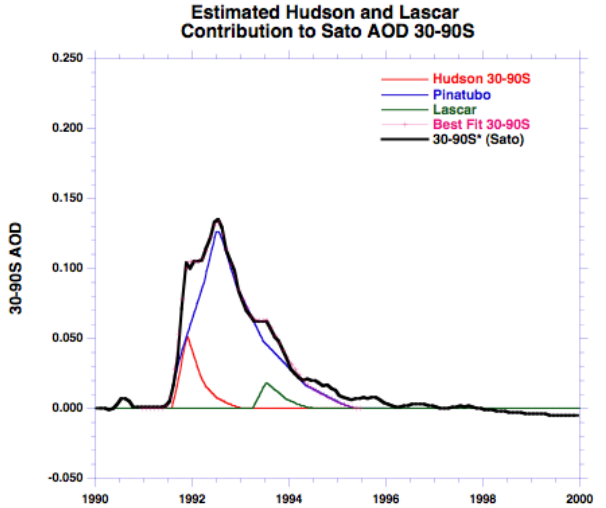
Figure 2. Observed zonal variability of the Pinatubo plume from Sato et al.